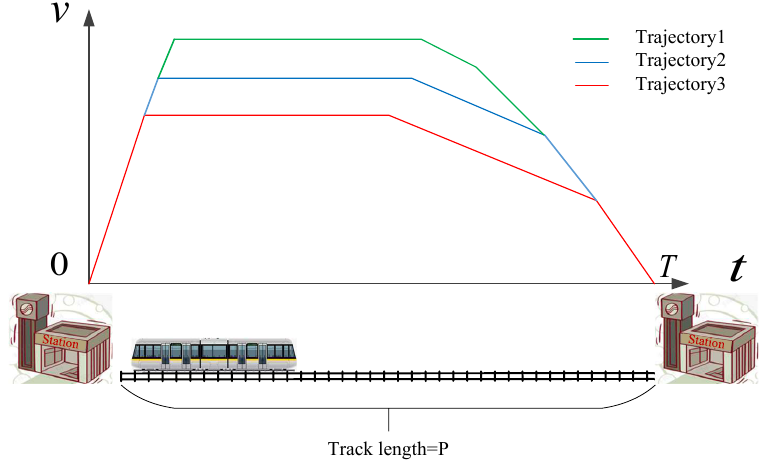
Figure 3. The scenario of an inter-station run for a single